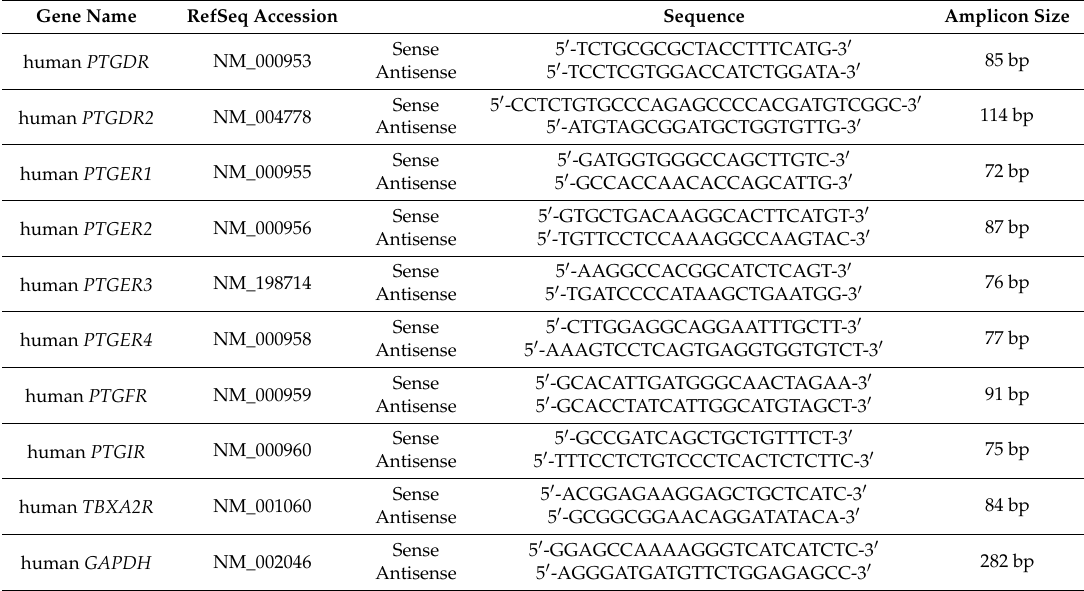
Table 1. Primer sequences for RT-PCR used in the present study